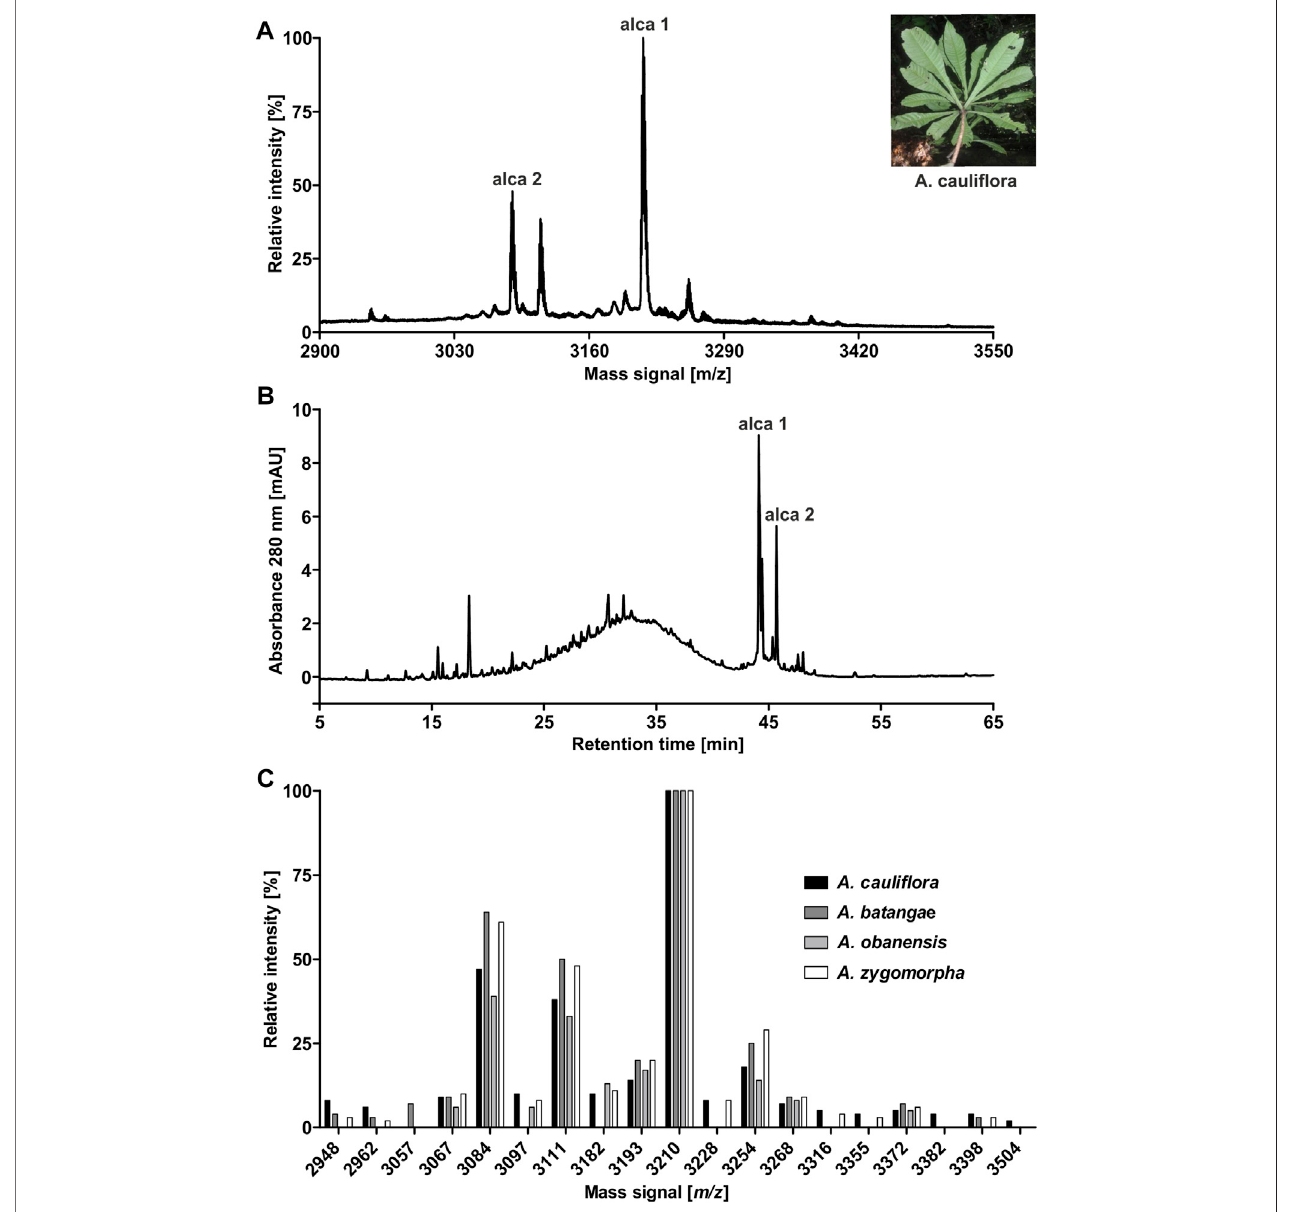
FIGURE 1 | Identi fi cation of peptides in extracts of A. cauli fl ora . MALDI-TOF-MS analysis was performed to evaluate mass signals of A. cauli fl ora peptides and other mid-weightmoleculesintherangeof2,900 – 3,550 Da.Thetwomajorsignalswereretrospectivelydenotedasalca1( m/z 3,211.4)andalca2( m/z 3,084.2)inthespectrum.A representative photograph of A. cauli fl ora is shown in the insert (property of David Kenfack under CC BY-NC 4.0 licence, http://korupplants.myspecies.info/) (A) . The analyticalHPLCchromatogramofthe A.cauli fl ora extractat280 nmabsorbanceisshownin (B) .Masssignalsintheinterestingrangeof2,900 – 3,550 DaoffourAllexis species, A. cauli fl ora, A. batangae, A. obanensis and A. zygomorpha, were compared as relative intensities of observed mass signals. For the comparative plot each mass signal in the spectra was independently normalized to the highest signal (C) .